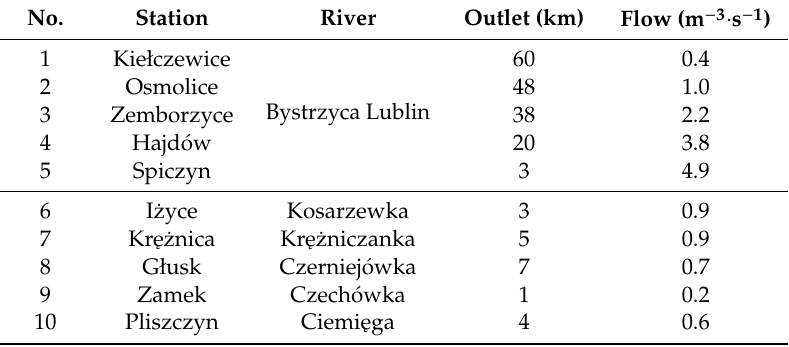
Table 1. Location of the station in the Bystrzyca river